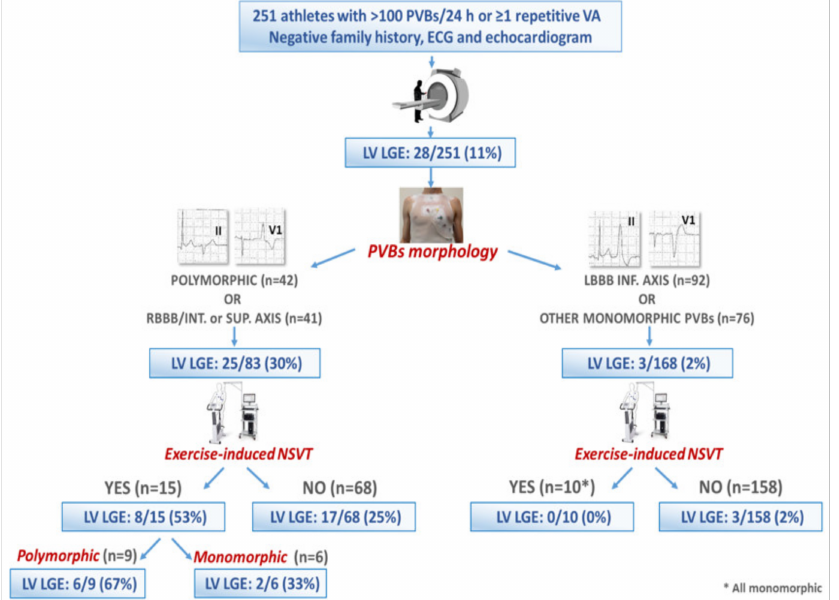
Figure 5. Summary of the main findings of a multicenter study on 251 athletes with ventricular arrhythmias, normal echocardiography and unremarkable ECG findings and a negative family history. Reproduced with permission from [23].